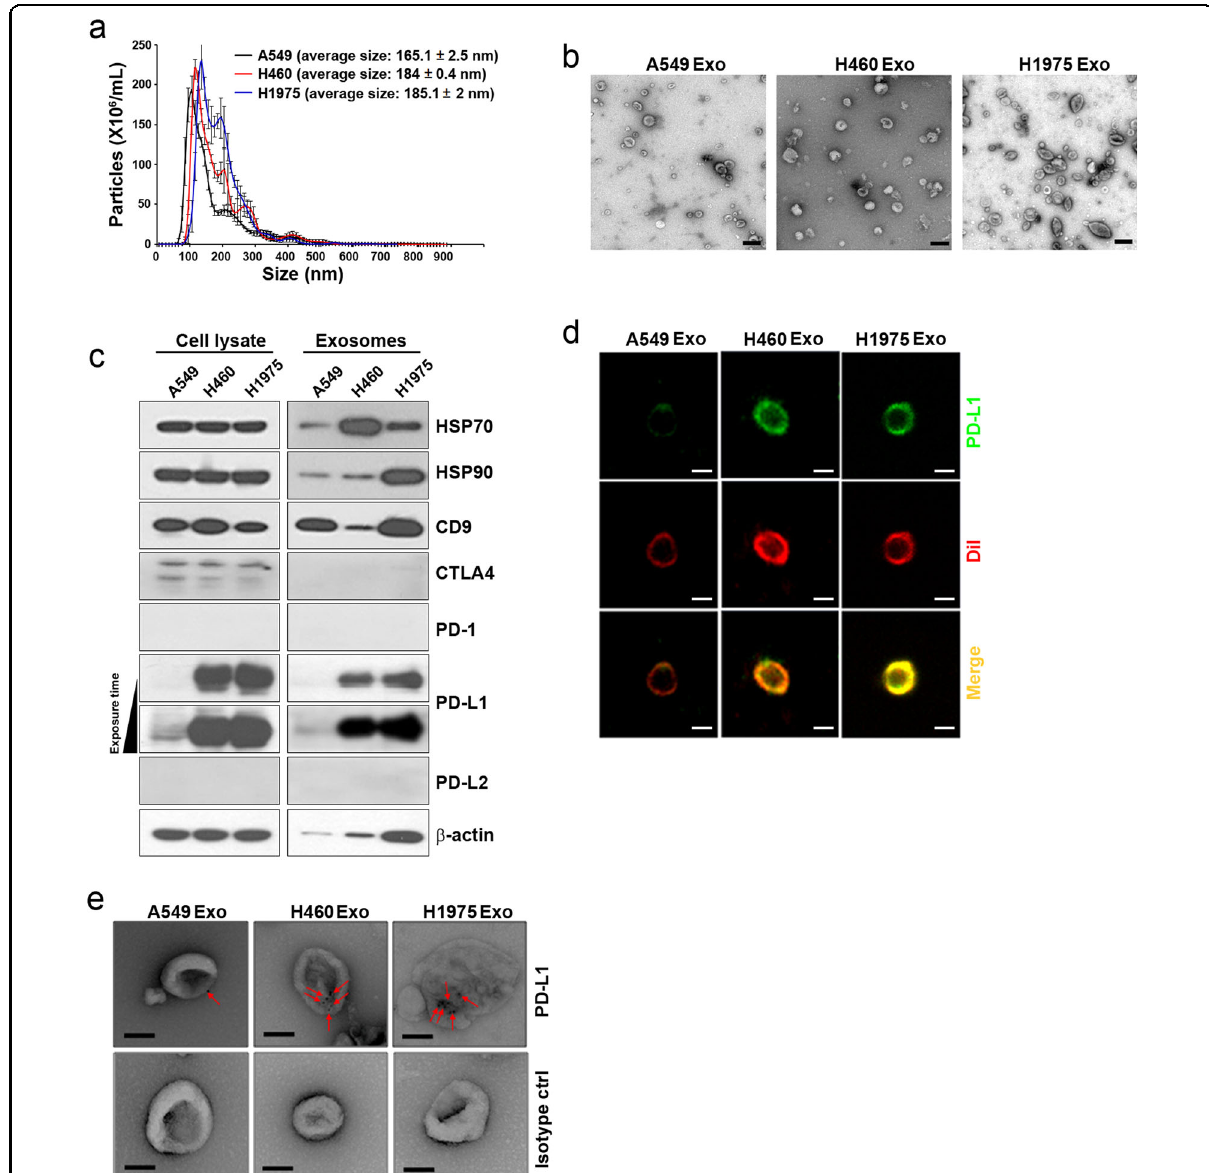
Fig. 2 Identi fi cation of PD-L1 in exosomes isolated from lung cancer cell lines. Exosomes were isolated by using ultracentrifugation as described in the methods. a Nanoparticle tracking analysis (NTA) of exosomes derived from A549, H460, and H1975 cells. b Representative electron micrograph of exosomes. Scale bars: 100 nm. c Western blot analysis was performed with 10 μ g of exosomal protein to validate the expression of PD- L1 and exosome biomarker proteins. d Representative immuno fl uorescence images of exosomes. Exosomes were immunostained with anti-PD-L1 (green fl uorescence) and DiI (red fl uorescence). Scale bars: 100 nm. e Representative immuno-electron micrograph of exosomes. The red arrows indicate PD-L1 expression. Scale bars: 100